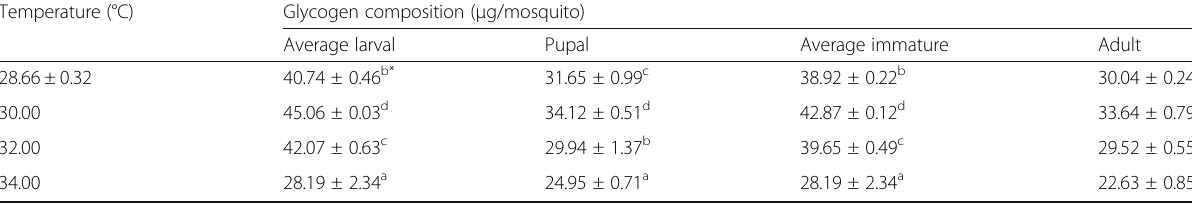
*Within a column, means (±SD) followed by same letter are not significantly different at p <0.05 according to Duncan multiple range test following analysis of variance